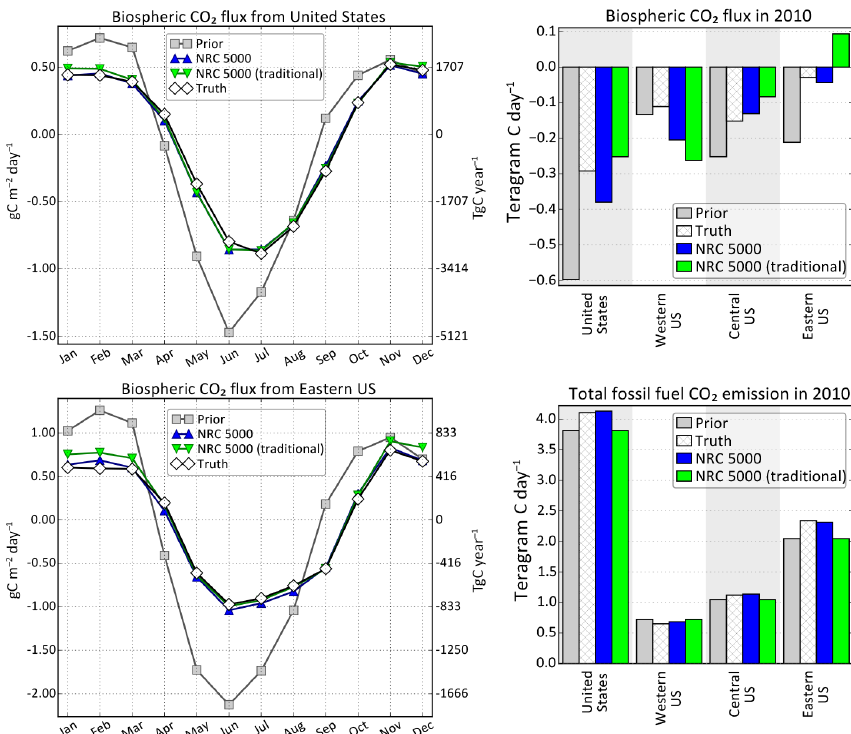
Figure 10. Monthly net biospheric CO 2 flux estimates for the NRC 5000 network scenario with and without 14 CO 2 observations along with prior and true fluxes aggregated for the conterminous and eastern US (left) and annual net biospheric and fossil fuel fluxes for the conterminous US and groups of neighboring regions (right). As discussed in the text, the NRC 5000 (traditional) inversion does not optimize fossil fuel fluxes and does not assimilate 14 CO 2 observations. For both the inversions above, large numbers of CO 2 observations in the NRC 5000 scenario drive the biosphere flux estimates toward true fluxes, while adding 14 CO 2 helps to address carry-over bias arising from erroneous specification of the fossil fuel